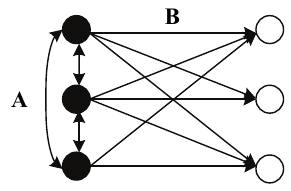
Fig.2 Topological Structure of the HMM